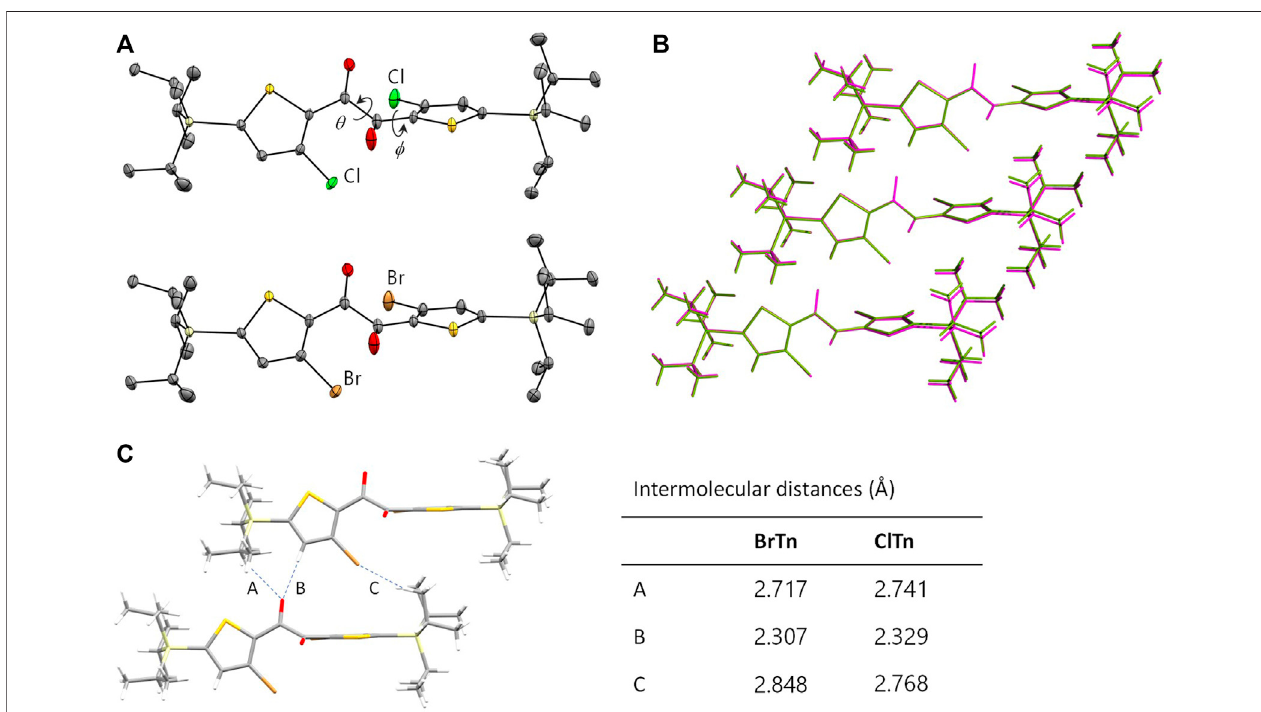
FIGURE2|(A) ORTEPdrawingsoftheX-raycrystalstructuresof ClTn(top) and BrTn(bottom) .Hydrogenatomsareomittedforclarityandthethermalellipsoids are set at the 50% probability level. (B) Overlaying three successive molecules in the crystals of ClTn (green) and BrTn (magenta). (C) Intermolecular short contact distances (Å) found in the crystal structures of BrTn and ClTn .